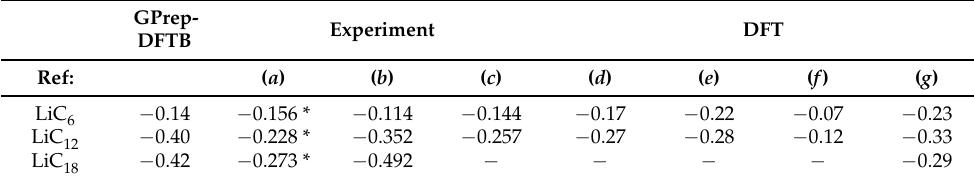
Table 4. Formation energies in eV per formula unit, calculated with GPrep-DFTB and compared to an overview of the experimental and theoretical results from other studies. Both DFTB and DFT values are variations in the total energy ∆ E int , while experimental values are variations in enthalpy ∆ H int where available—otherwise they are variations in free energy